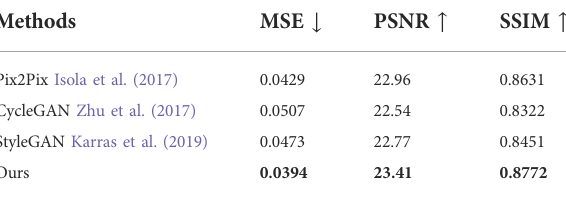
TABLE 4 Comparison results of the objective evaluation on single modal synthesis (T2 →